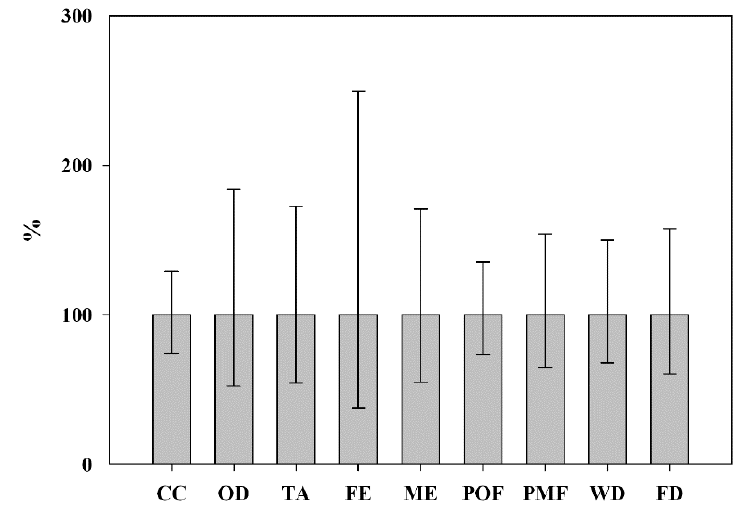
Figure 5. Graphical representation of confidence interval (95%) for impacts related to the overall production chain of 1 kg of bio-based BDO.